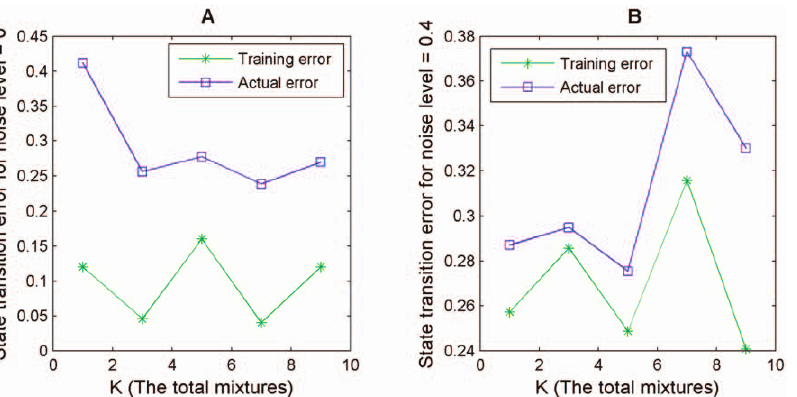
Figure 4. Model selection strategy adopted for choosing the best value of K using the training set error as a criterion for selection. This figure is a plot of values shown in Table 2. Here the training error along with the state transition error for different K values is plotted for noise levels 0 and 0.4. The rules were generated for node J (indegree 9) of the 10 node network. We can see that generally, a higher training set error corresponds to a higher state transition error and vice versa.